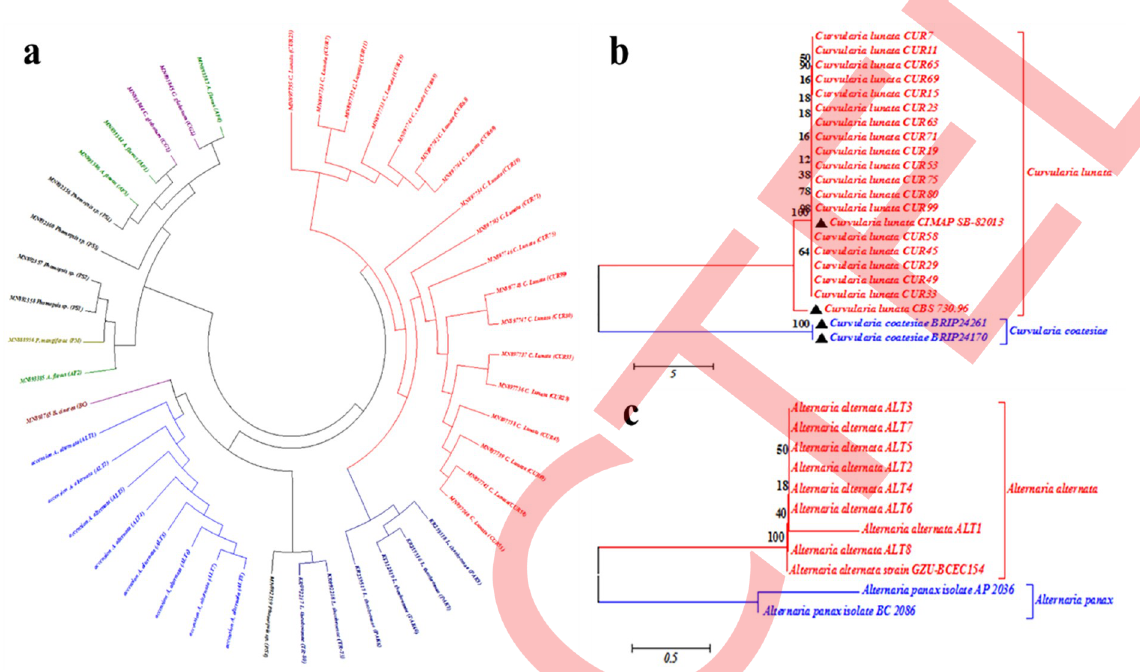
Fig 1. Evolutionary history of ITS region from all isolates (a) and multigene sequence analysis of Curvularia (b) and Alternaria (c)